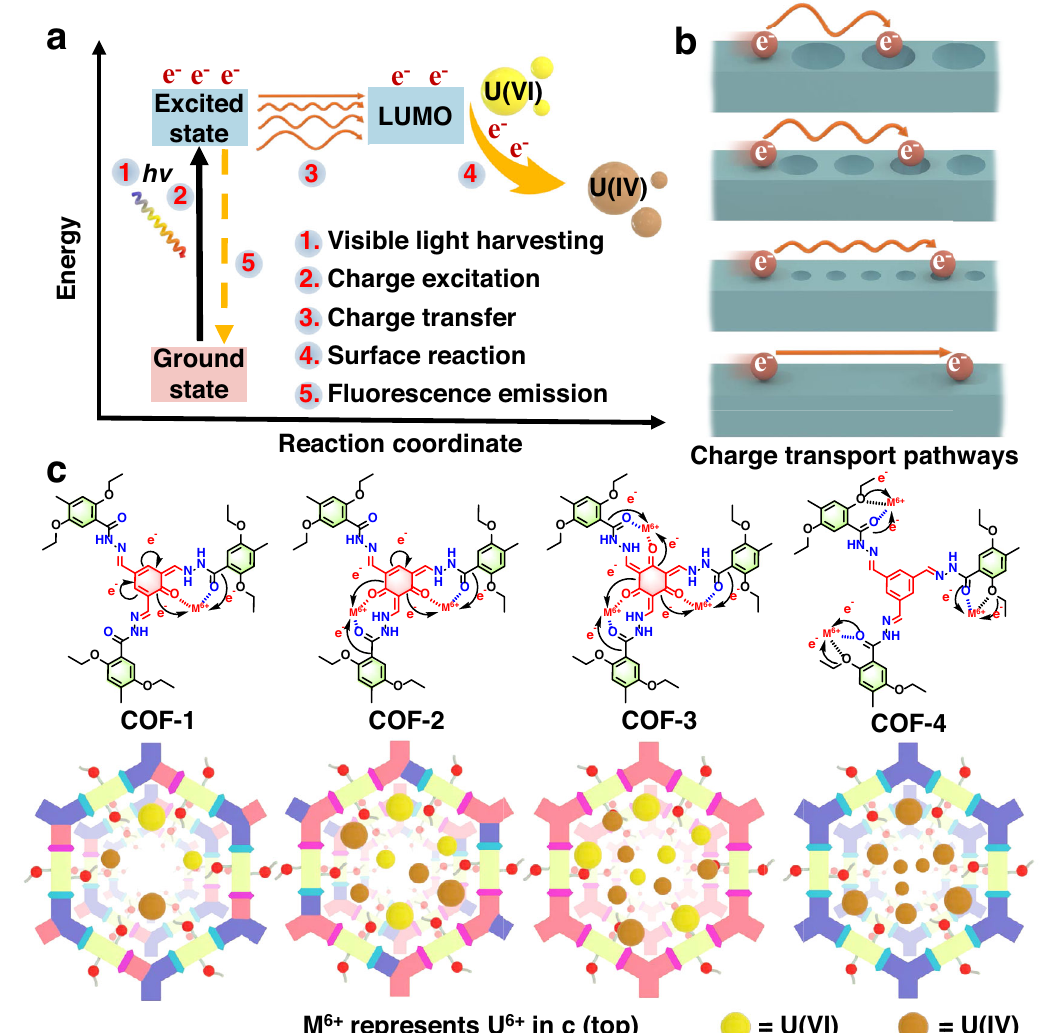
Fig. 1 | Overview of the electron excitation processes and charge carrier utili- zationinCOFs.a Schematicillustrationofchargecarrierseparationandutilization by COF photocatalysts, highlighting the energy levels involved in the charge transfer processes. b Illustration of charge transfer from a COF donor to a U(VI) acceptor (highlighting the different utilization ef fi ciency), which can be optimized